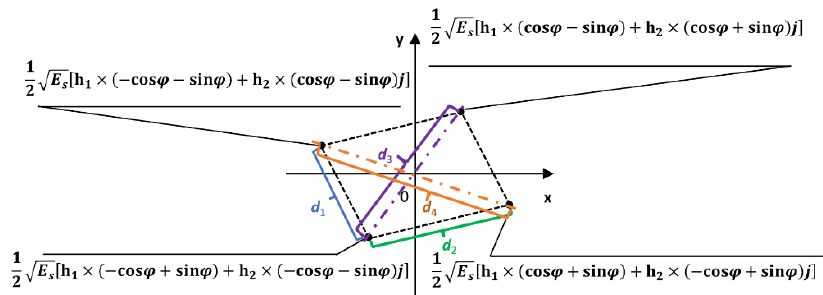
Figure 3. Signal constellation after the SSD diversity deinterleaving at the receiver.